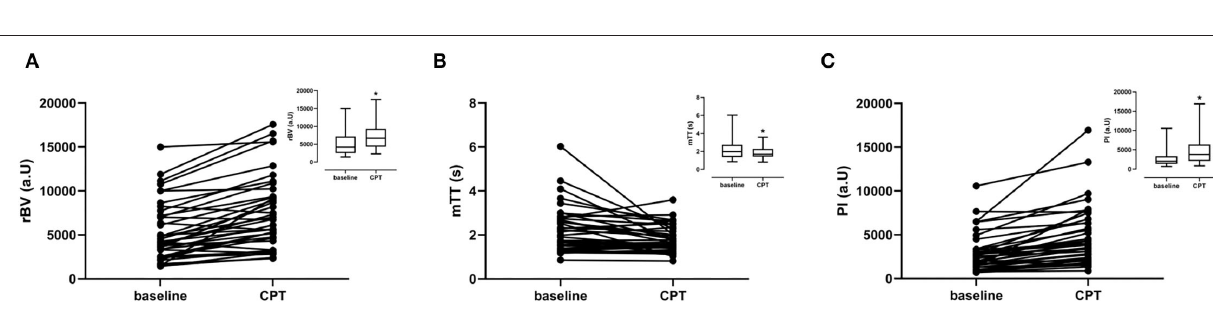
Frontiers in Cardiovascular Medicine |